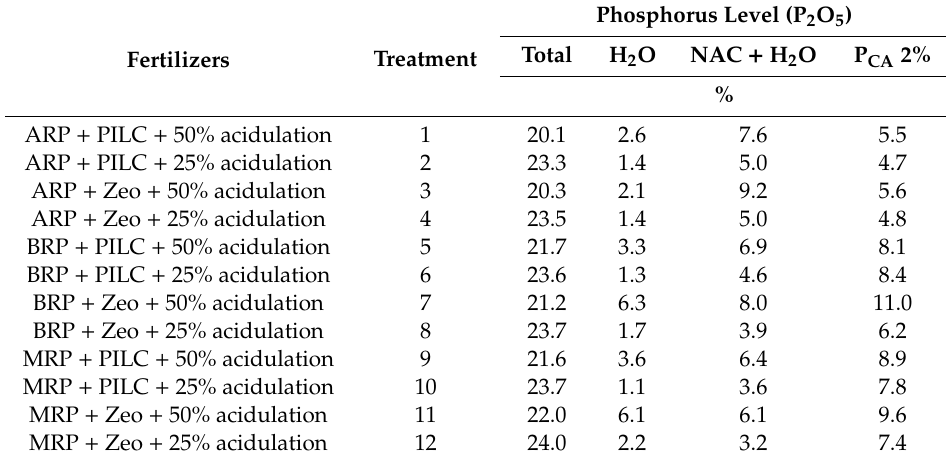
Table 2. Characterization for the total P 2 O 5 , water soluble, neutral ammonium citrate + water (NAC + H 2 O) and 2% citric acid (P CA 2%) soluble P of phosphate fertilizers partially acidulated plus the additives pillared clay (PILC) and zeolite